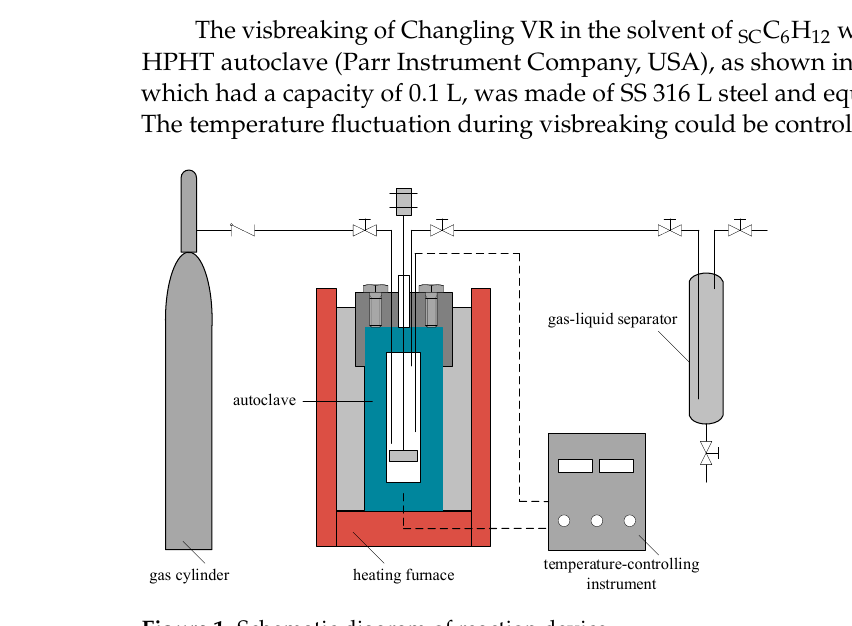
Figure 1. Schematic diagram of reaction device.